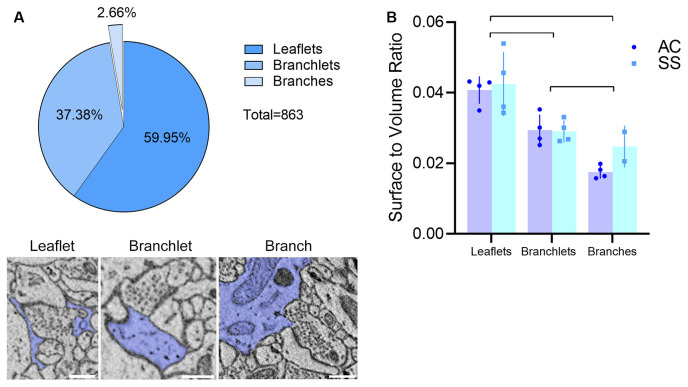
(A) Top: PAP composition in our dataset (n = 863, four animals). Bottom: examples of the leaflet, branchlet, and branch depicted in blue and surrounding an axo-spinous synapse. The scale bar is 350 nm for all panels. (B) Average surface-to-volume ratio values in AC and SS (mixed-effects analysis, n = 4). Lines indicate significant pairwise comparisons (p < 0.05, Bonferroni corrected).